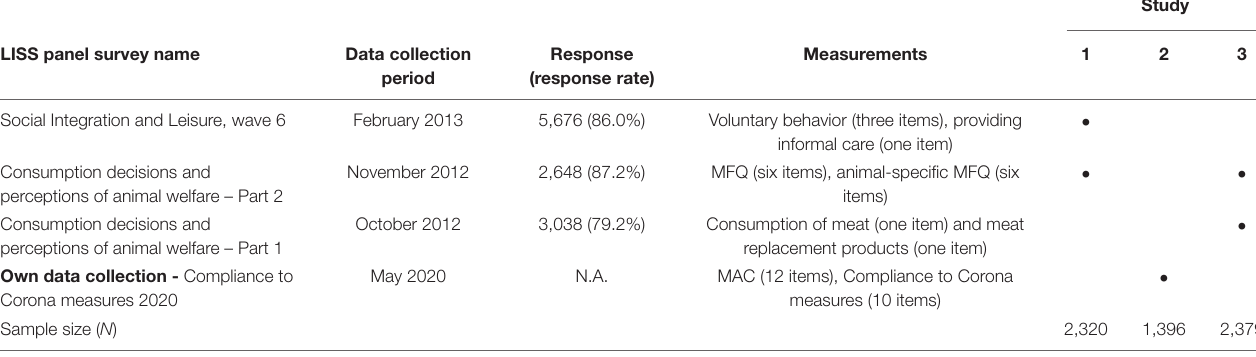
TABLE 1 | Overview of surveys and participants across studies 1, 2, and 3.